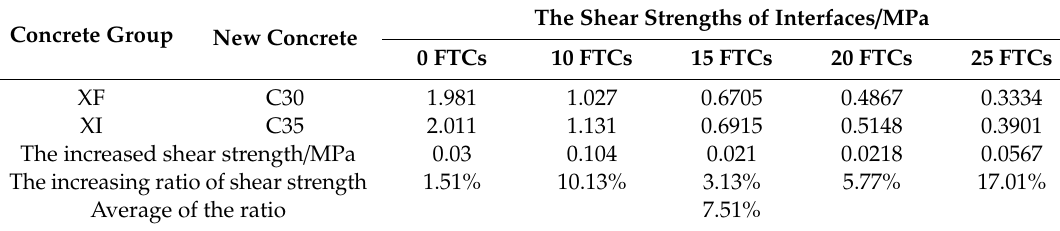
Figure 8. The shear strengths of interfaces by using C30 and C35 as the new concrete. Table 5. The ratio of increased shear strength by using C35 as the new